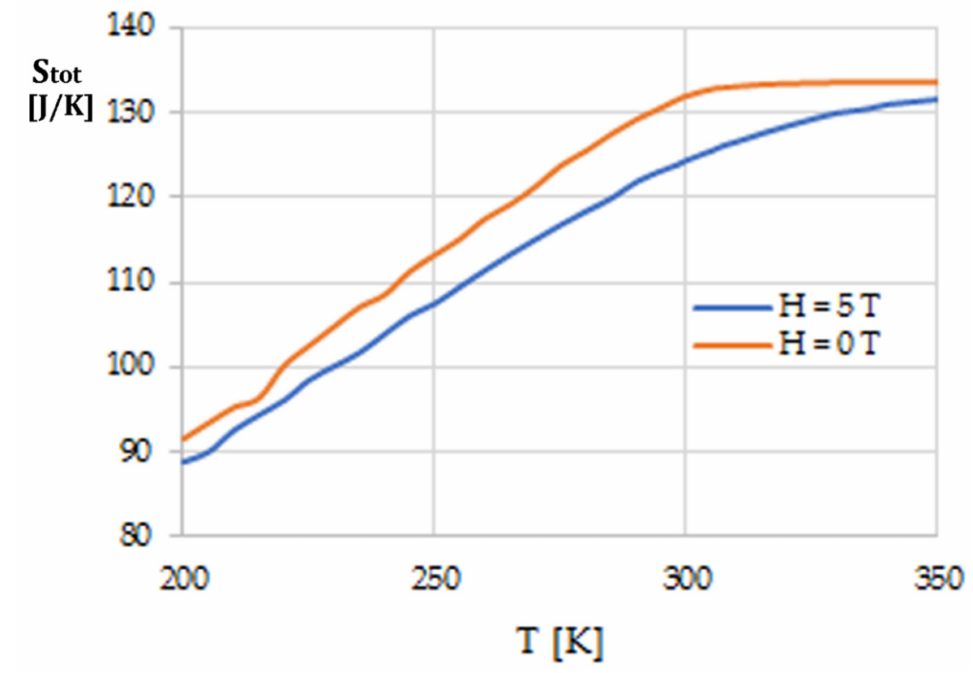
Figure 11. Theoretical values of 0T and 5T iso-field curves representing the entropy trend as a function of